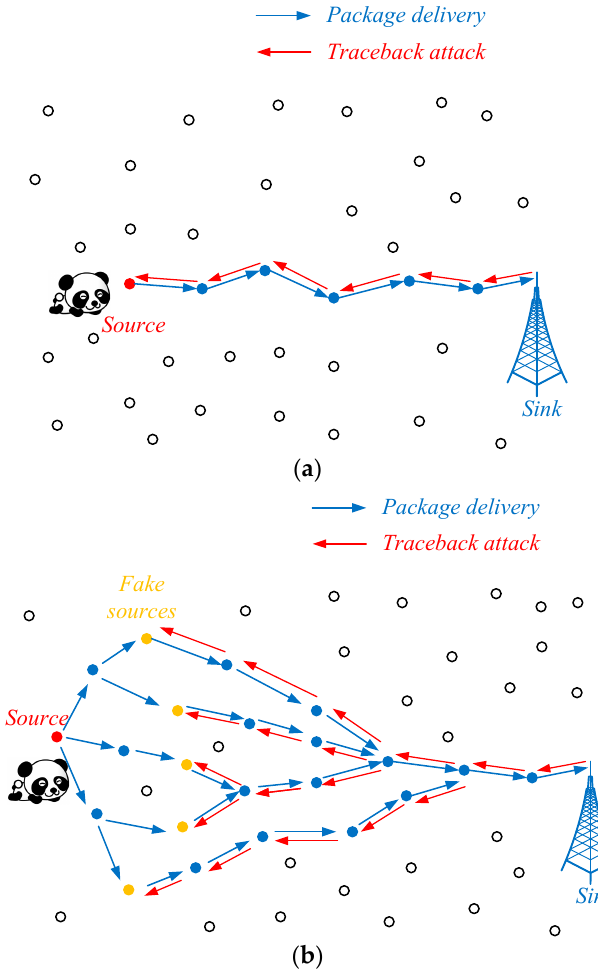
Figure 2. The trace-back attack in different networks. ( a ) Networks without source-location privacy protection; ( b ) networks with source-location privacy protection.